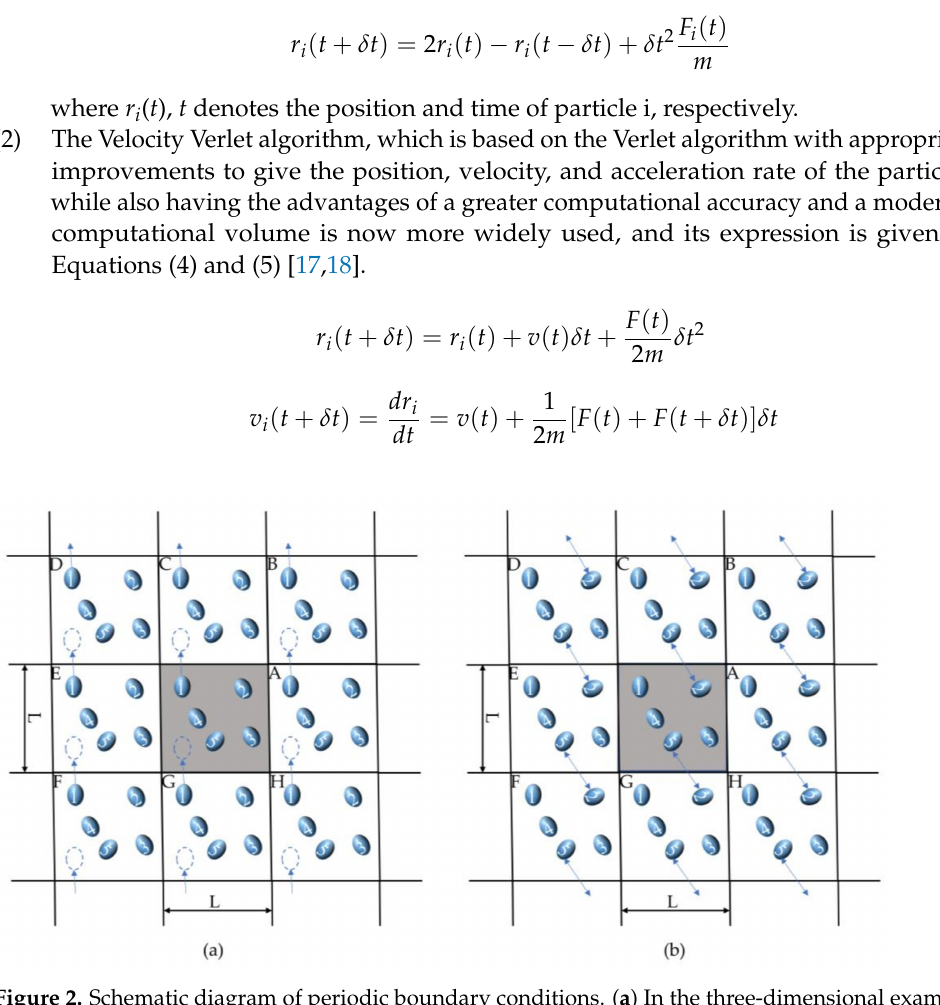
Figure 2. Schematic diagram of periodic boundary conditions. ( a ) In the three-dimensional example, molecules can freely traverse the faces of each multidimensional data set; ( b ) Intermolecular forces adopt the nearest mirror